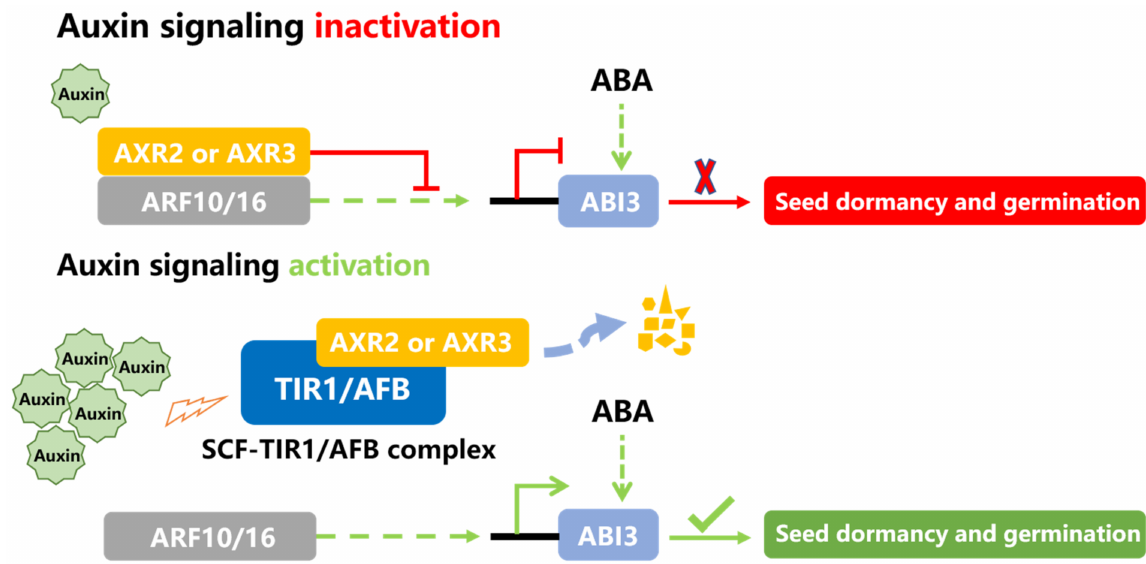
Figure 4. A proposed model for the effect of the ABA–auxin interaction on the control of seed dormancy/germination modified, modified on the basis of the work of Liu et al. [60]. The solid arrows and lines indicate direct regulation, and the dotted arrows indicate indirect regulation. The ABI3 box indicates the ABI3 gene